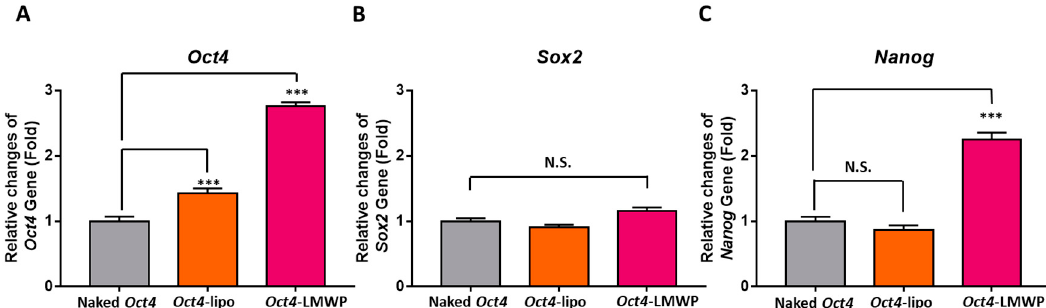
Figure 7. Gene expression of stemness markers in MEF cells. Changes in the expression of stemness marker genes ( A ) Oct4 , ( B ) Sox2 , and ( C ) Nanog in MEF cells treated with Oct4 -Lipo or Oct4 -LMWP complexes were confirmed by quantitative RT-PCR. The bar graph represents the relative fold changes in gene expression, which were determined by the cT value of each sample normalized to that of β -actin . Statistical significance between groups was analyzed using the Student’s t -test. The level of significance is represented as *** p <